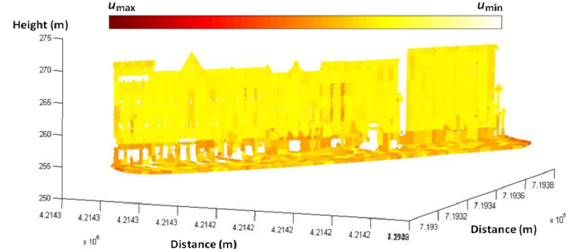
Figure 3: Uncertainty distribution map of a busy neighborhood-1 presented in the form of color coded heat map (with yellow being the lowest and red the highest level of uncertainty). The map clearly shows that the bottom part of the environment (close to the ground) is highly uncertain whereas the top part is generally stable.